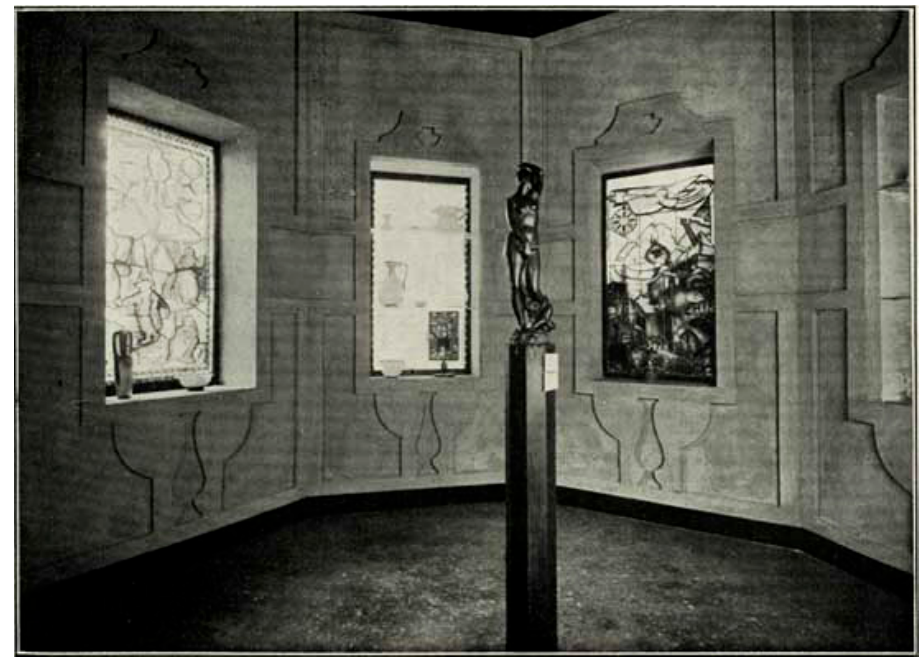
Figure 2. Exhibition hall in the central pavilion of the XVI Biennale di Venezia in La Biennale—Catalogo u ffi ciale illustrato , ed. Carlo Ferrari, 1928, p. 100.